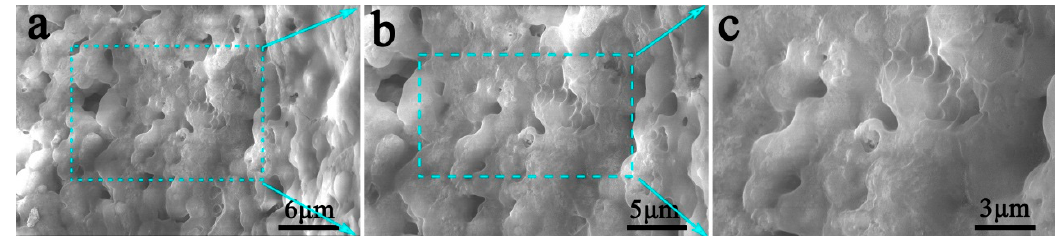
Figure 3. Cross-sectional SEM images of cured PRC. ( a ) Low magnification, ( b , c ) High magnification.